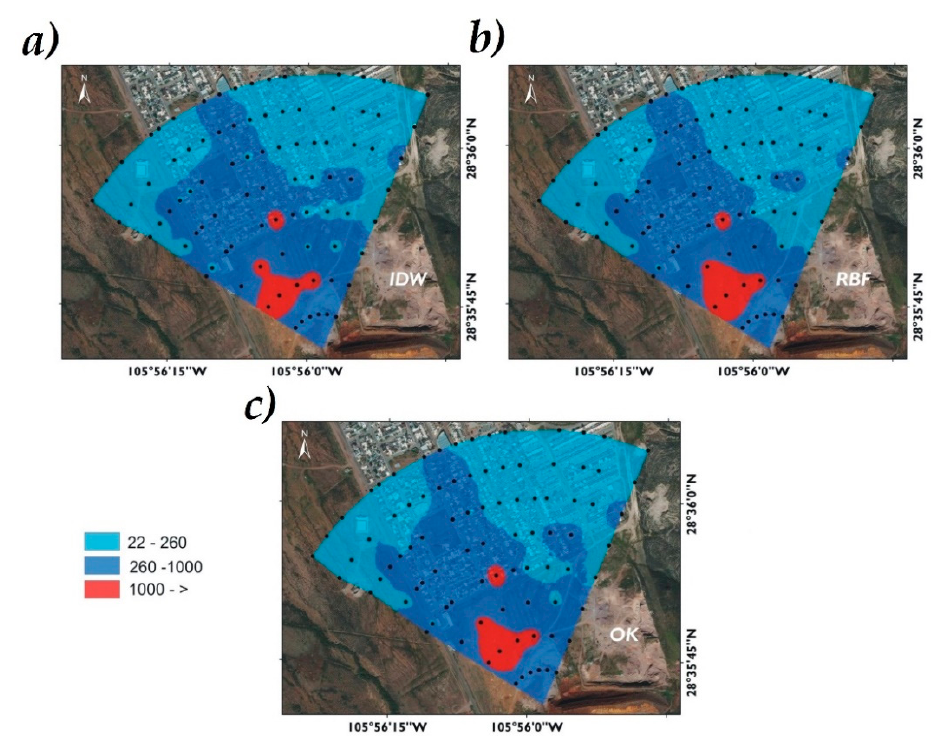
Figure 5. Spatial distribution of As in San Guillermo obtained by interpolation methods: IDW ( a ), RBF ( b ), and OK ( c ). Samples ( ● ), Industrial use ( ■ ), Contaminated soil ( ■ ), Severely contaminated soil ( ■ ).